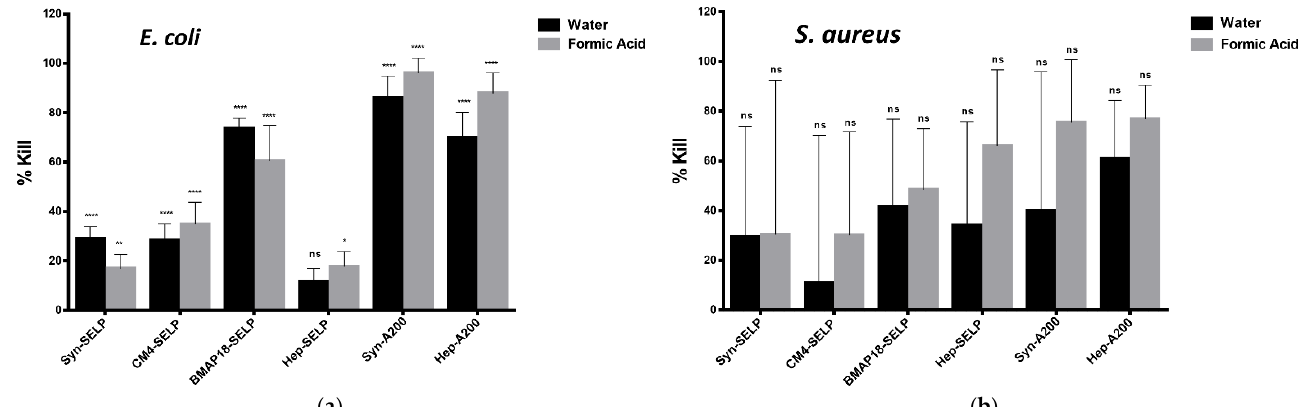
Figure 3. Antimicrobial activity of AMP-SELP and AMP-A200 hybrid materials assessed by direct contact with the surface of the films against ( a ) Escherichia coli and ( b ) Staphylococcus aureus . Cell suspensions inoculated in empty wells were used as reference for 100% survival. Error bars represent means ± SD (ns, non-significant; * p ≤ 0.05; ** p ≤ 0.01; *** p ≤ 0.001; **** p ≤ 0.0001). Experiments were performed in triplicate in independent days with three replicates each (see Tables S4 and S5 for CFU enumeration). No statistical significance was found between films prepared using water or formic acid as sol- vents.